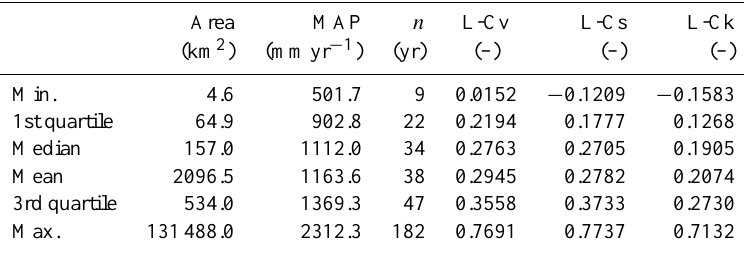
Table 1. Summary of the Austrian, Italian and Slovakian national data sets. Information on the distribution of catchment area, MAP, record length ( n ) and sample L-moment ratios of the annual flood sequences is